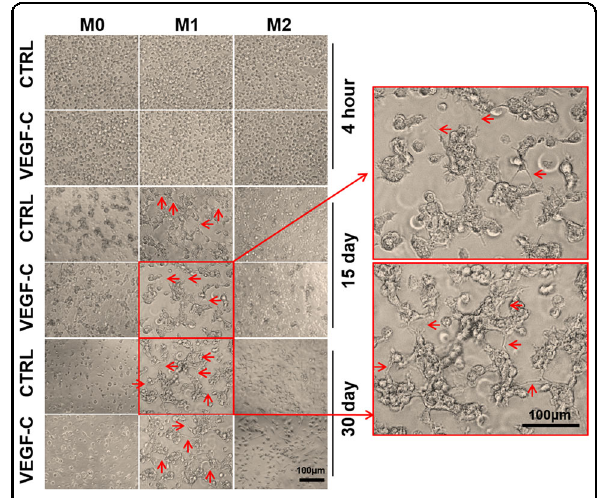
Fig. 5 Primary BMDMs formed tube-like structures in vitro. Behavior of BMDMs with or without VEGF-C treatment in a tube formation assay containing 2 × 10 5 cells/well in Matrigel for 4 h, 15 days, and 30 days